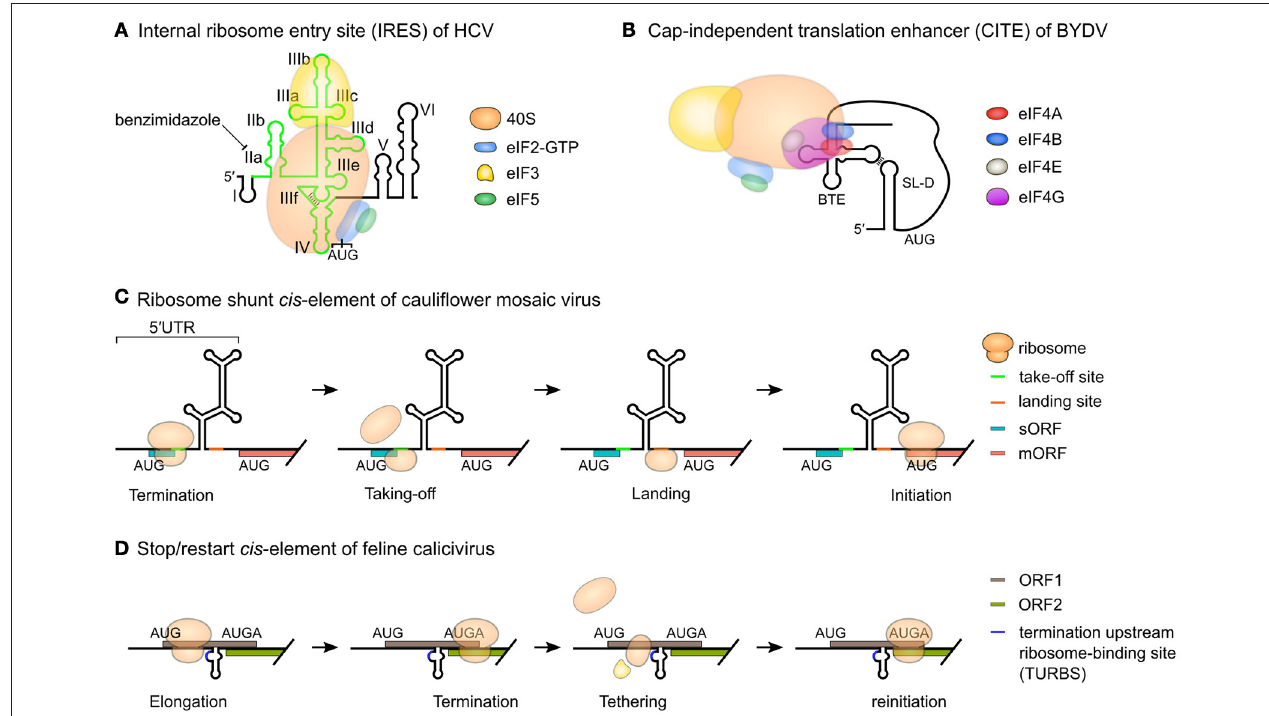
FIGURE 7 | Functions of viral RNA structures. Viral structured RNA elements are important in viral replication, transcription and translation. Many RNA viruses hijack the host translation machinery and utilize unusual translation mechanisms for protein synthesis. (A) Internal ribosomal entry site (IRES) of HCV recruits eIF3 and 43S preinitiation complex to promote a cap-independent translation mechanism called IRES-mediated translation. The domains II to IV of HCV (light green) are the key RNA motifs of IRES. This unusual translation mechanism can be inhibited by benzimidazole by targeting the domain IIa. The domain IIIf is a pseudoknot. (B) Cap-independent translation enhancer (CITE) of BYDV (BYDV-like translation enhancer, BTE) recruits eukaryotic initiation factors and 40S ribosomal subunit, forming long-range interactions with stem-loop-D (SL-D) to promote translation. (C) Unusual translation mechanisms can also occur in some polycistronic viral RNAs. The 5 ′ UTR of cauliflower mosaic virus is long and highly structured. The highly structured region contains multiple upstream AUGs. A highly structured 5 ′ UTR with multiple upstream AUGs could inhibit translation of the main open reading frame (mORF) of a eukaryotic mRNA. Cauliflower mosaic virus overcome this problem with ribosome shunt cis -element. A ribosome first translate the small ORF (sORF) at the viral 5 ′ UTR. During translation termination, the ribosome dissociates but the take-off site (the sequence surrounding the termination codon) induce ribosome shunting. This allows the ribosome to bypass the highly structured region of the 5 ′ UTR, land on the landing site, followed by translation of the mORF. (D) Feline calicivirus contains two ORFs with a slightly overlapping sequence AUGA. A structured motif called stop/restart cis -element located upstream of AUGA permits effective reinitation and translation of the second ORF. A termination upstream ribosome-binding site (TURBS) located in the RNA structure allows tethering of 40S ribosomal subunit and eIF3. This promotes reinitiation of the second